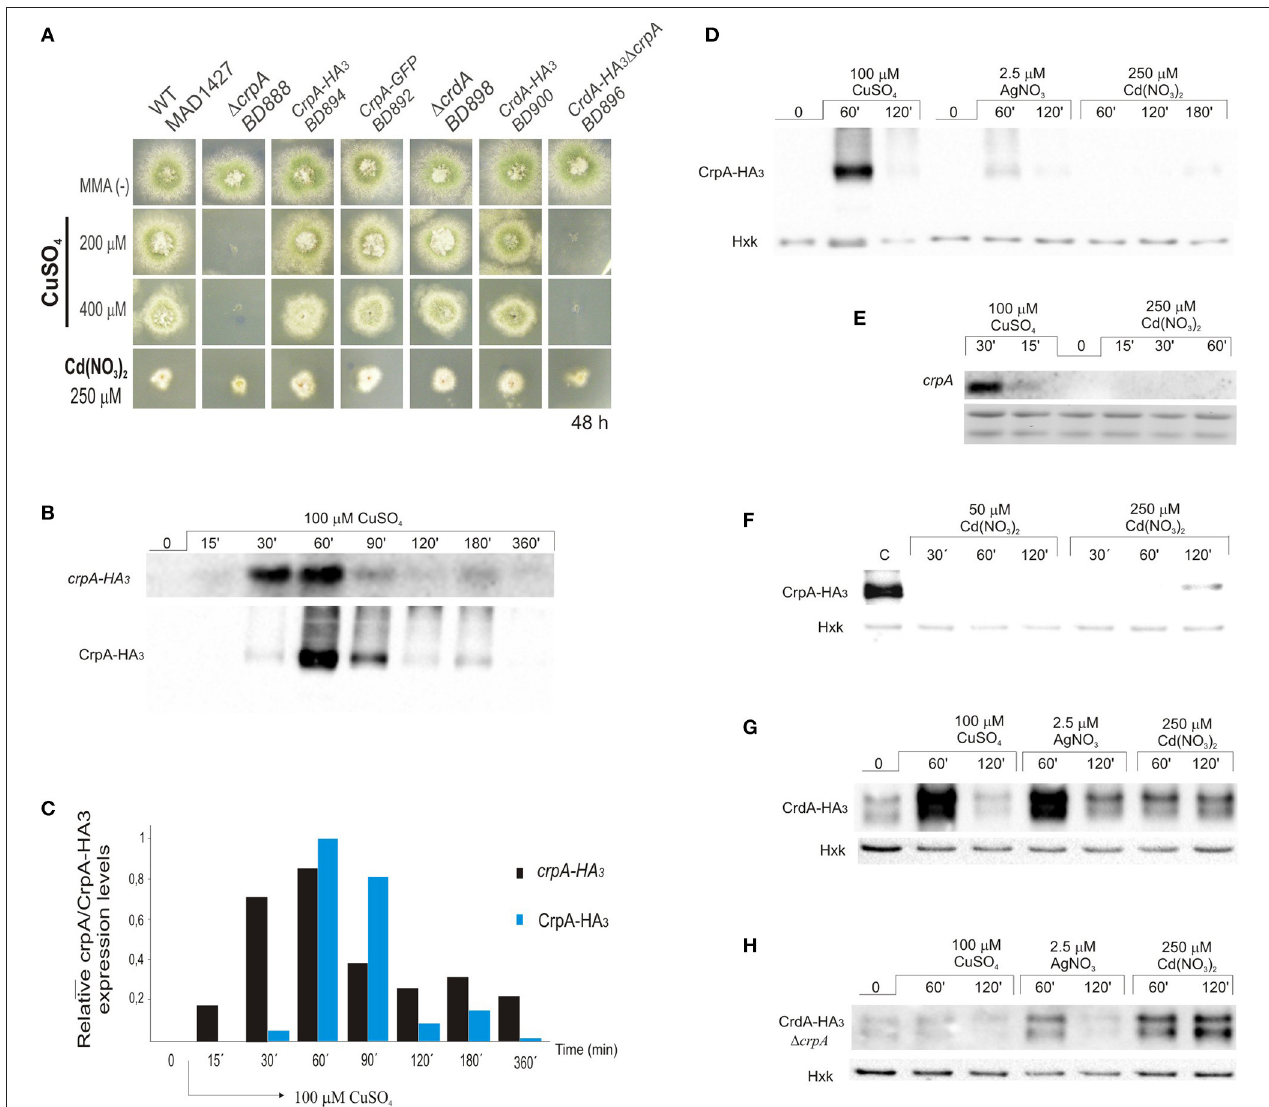
FIGURE 3 | CrpA-HA 3 and CrdA-HA 3 induction by heavy metal ions. (A) Copper sensibility assay of tagged CrpA and CrdA mutant strains. (B) Northern blot and Western blot showing changes in crpA-HA 3 transcript and CrpA-HA 3 expression levels after addition of 100 µ M of CuSO 4 and monitored at the indicated times. Images correspond to the area of interest. (C) The graph shows crpA-HA 3 transcript and CrpA-HA 3 protein expressions relative to the corresponding loading controls, rRNA and hexokinase respectively. Average pixel intensity for each band was calculated with Image J (version 4.0; Fujifilm, Valhalla, NY). (D) Comparison of CrpA-HA 3 induction pattern by different metal salts [100 µ M CuSO 4 , 2.5 µ M AgNO 3 , and 250 µ M Cd(NO 3 ) 2 ]. Images correspond to the area of interest. (E) Northern blot showing changes in crpA expression after addition of 100 µ M of CuSO 4 but not during 1 h treatment with 250 µ M of Cd(NO 3 ) 2 . (F) Western blot comparing Cd-induced CrpA-HA 3 expression after 50 µ M and 250 µ M of Cd(NO 3 ) 2 addition. Western blot showing changes in HA 3 tagged version of CrdA in a wild-type (G) and null crpA (H) background induced by different metal